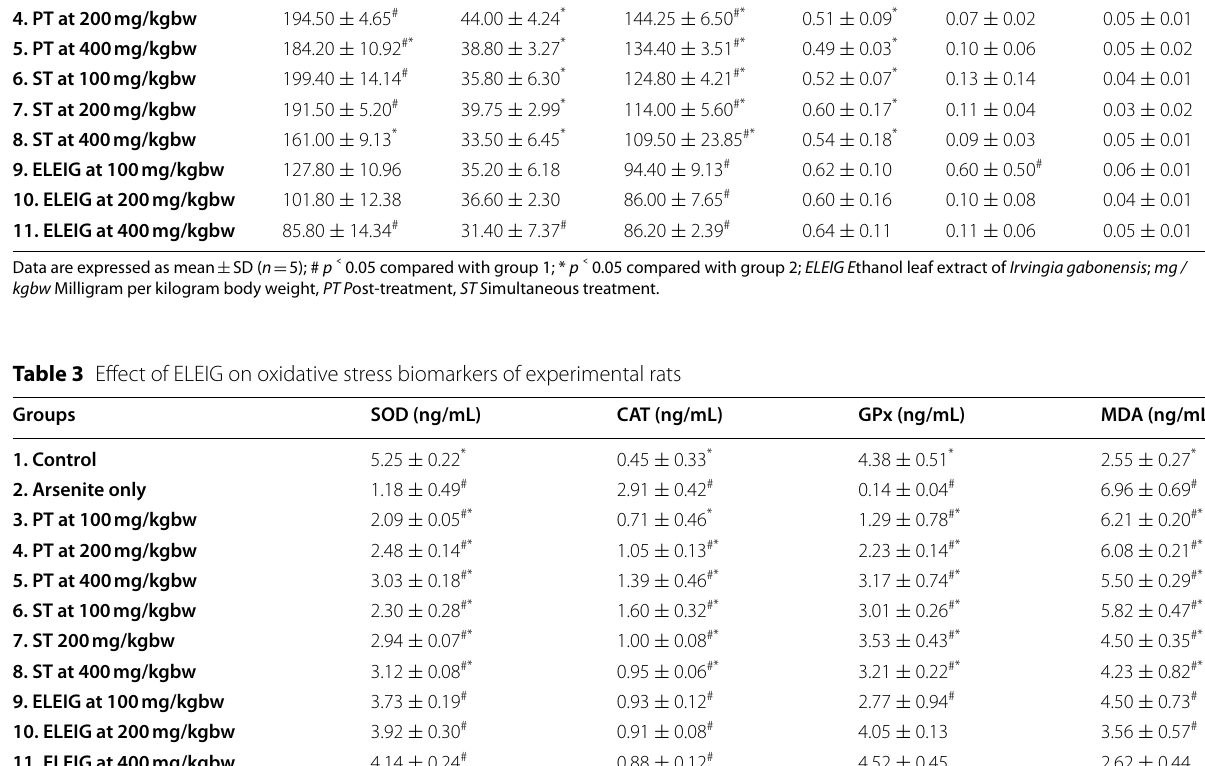
Data are expressed as mean SD ( n 5); # p ˂ 0.05 compared with group 1; * p ˂ 0.05 compared with group 2; ELEIG E thanol leaf extract of Irvingia gabonensis , mg / ± = kgbw Milligram per kilogram body weight, PT Post-treatment, ST Simultaneous treatment.